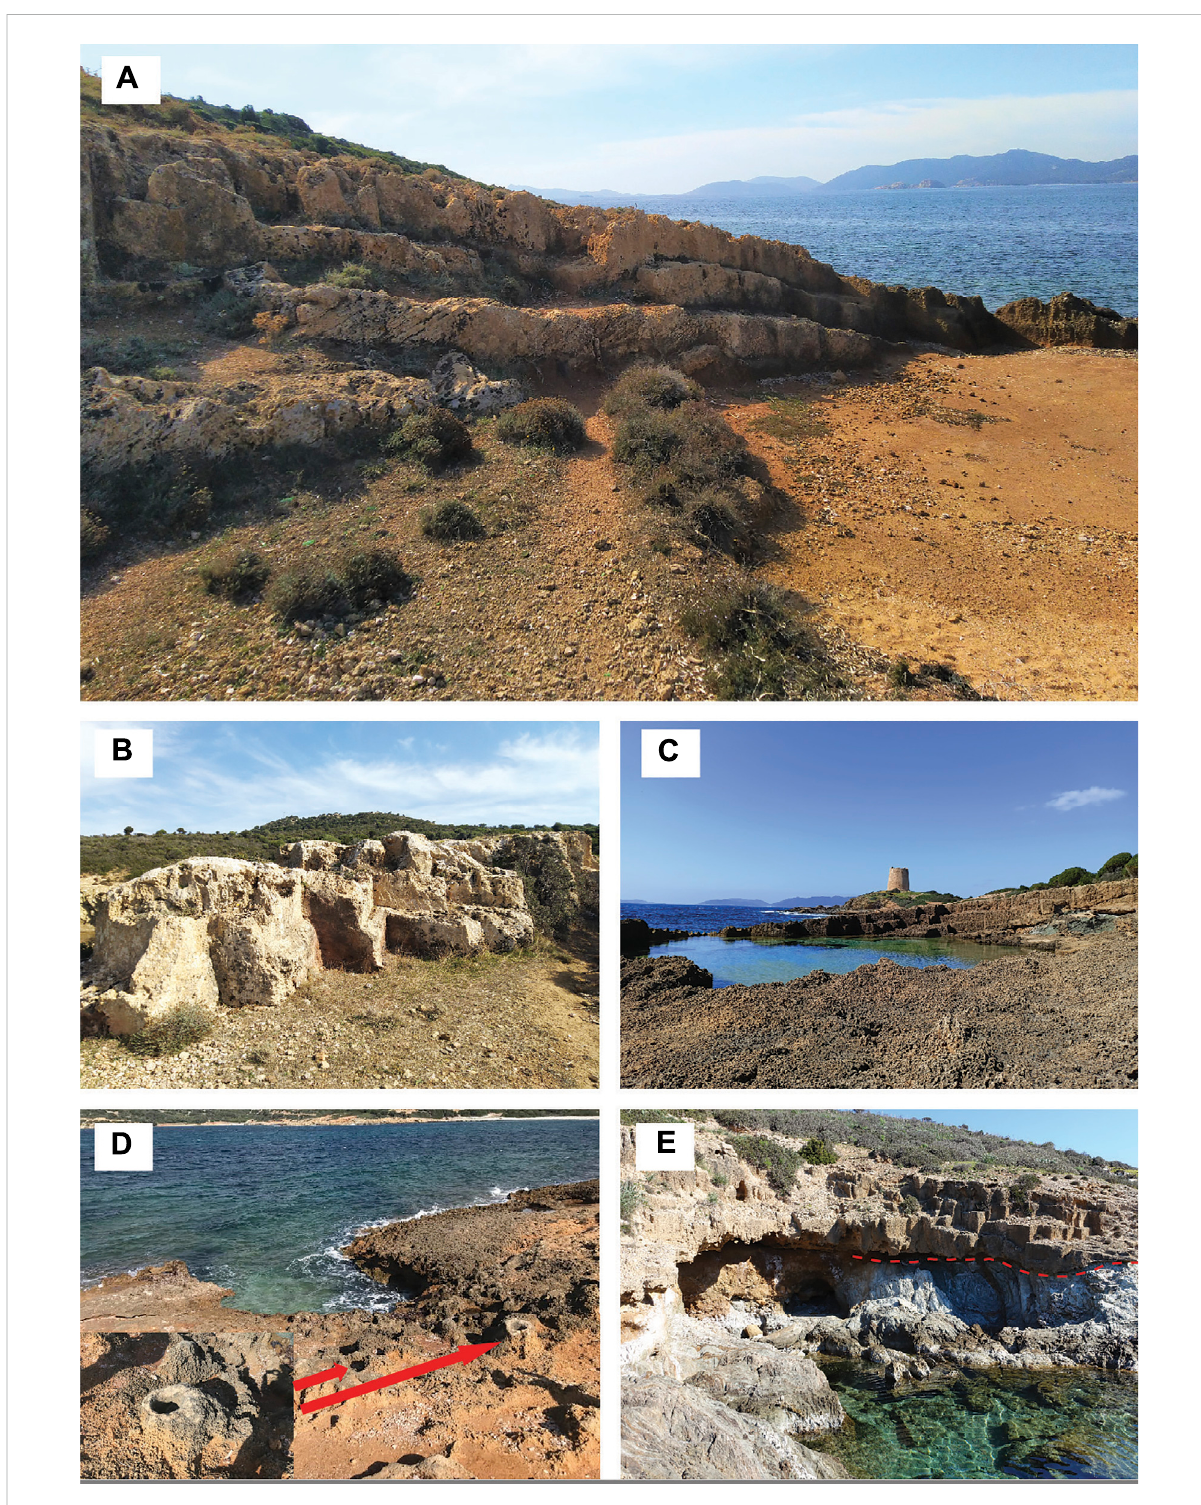
FIGURE 9 (A,B) Sandstone quarries close to the Piscinnì beach; (C) sandstone quarry on the south-east side of the Piscinnì promontory where the homonym Spanish tower rests; (D) holes into the rocky substrate likely carved to wedge in wooden poles supporting a crane; (E) cantilever terraces excavated into the sandstone above the metamorphic